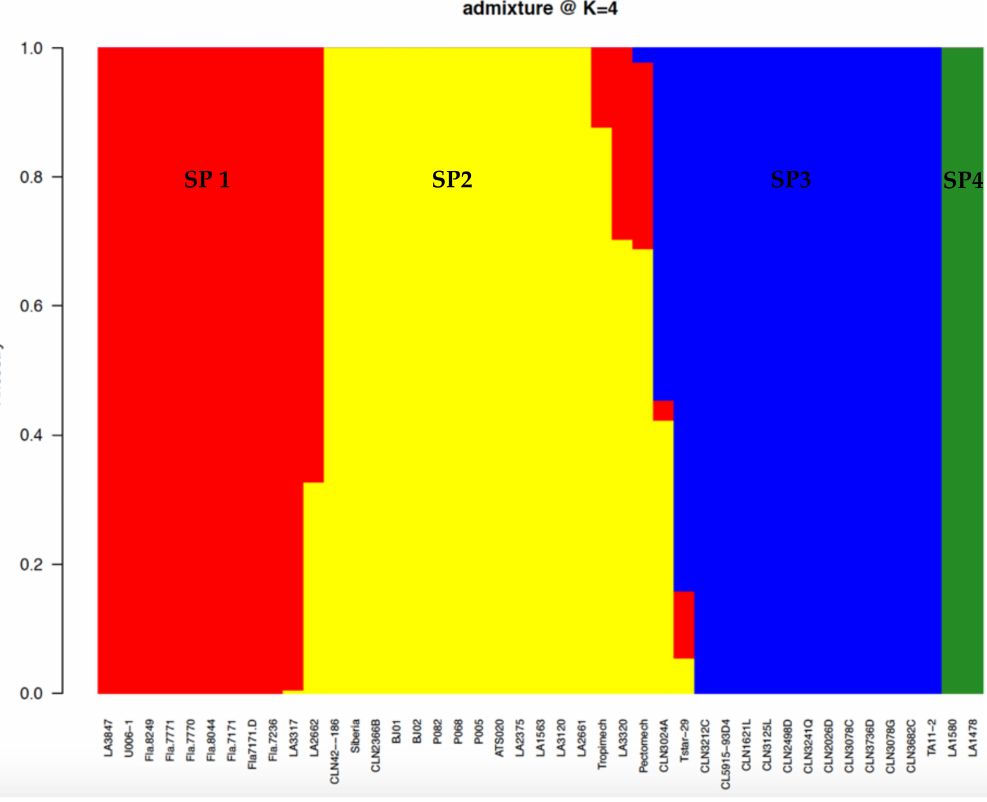
Figure 5. Population structure in a tomato germplasm collection. Each entry’s genome is divided into colored segments following the proportion of the estimated ancestry membership coefficient in the four subpopulations. Sub-populations SP1, SP2, SP3, and SP4 are represented by red, yellow, magenta, and green,